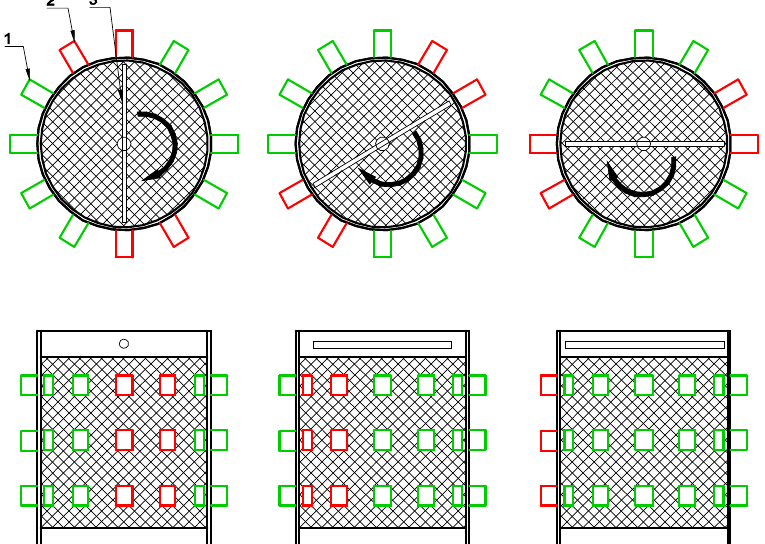
Figure 4. Scheme of operation of microwave generators heating the fermentation reactor. 1—green EMR, ON; 2—red EMR, OFF; 3—stirrer.